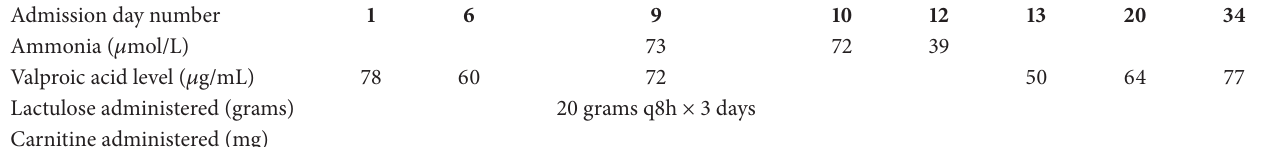
Table 1: Lactulose and carnitine administration and corresponding ammonia and valproic acid levels.